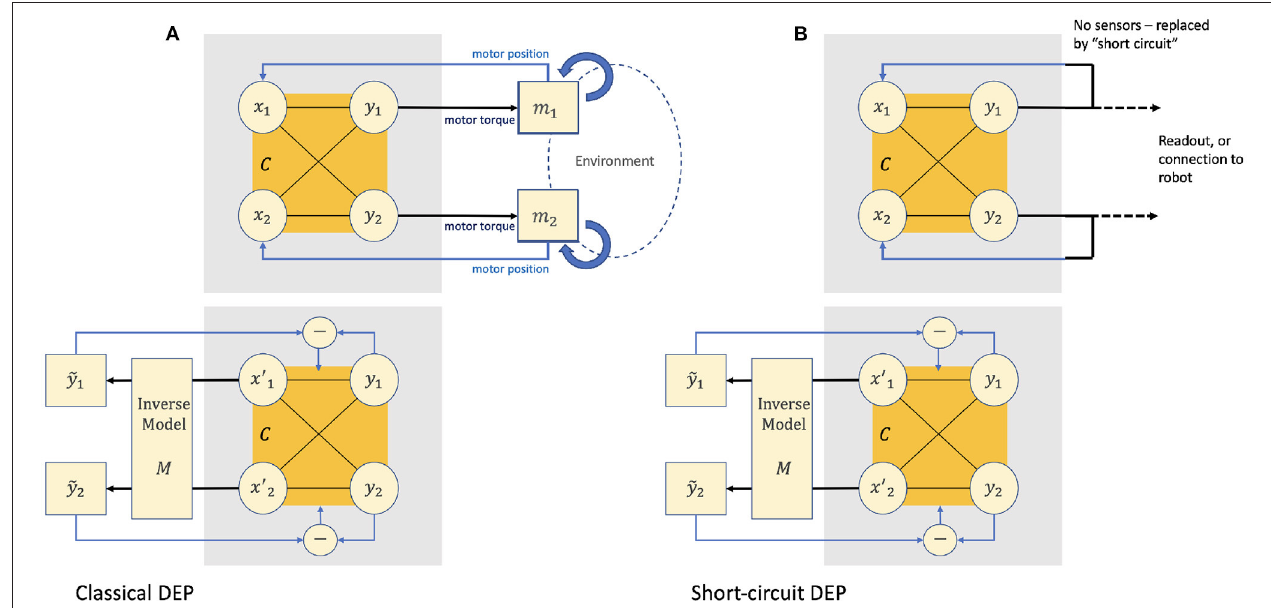
FIGURE 1 | In the “classical” version of Differential Extrinsic Plasticity (DEP) comprises two overlapping dynamical systems. [ (A) , top] The input layer x of a feed-forward neural network C is driven by the motor positions. The output layer y drives the motor torques. These motors operate on the agents body in a given environment (potentially with collisions) and the resulting motor positions x t + 1 will be fed back to the input to start the cycle again. [ (A) , bottom] The positional information returned as x t + 1 is also fed to an inverse model that infers the rate of change of the motor torques ˜˙ y that would have generated them in the absence of environmental feedback. The difference between ˜˙ y and the actual rate of change ˙ y captures the environmental effects of the agent’s actions. This difference is then used to modify the weights of C. In the “short-circuited version” of DEP [ (B) , top and bottom] there are no motors or sensors; the output y of the network is fed directly back to the input x